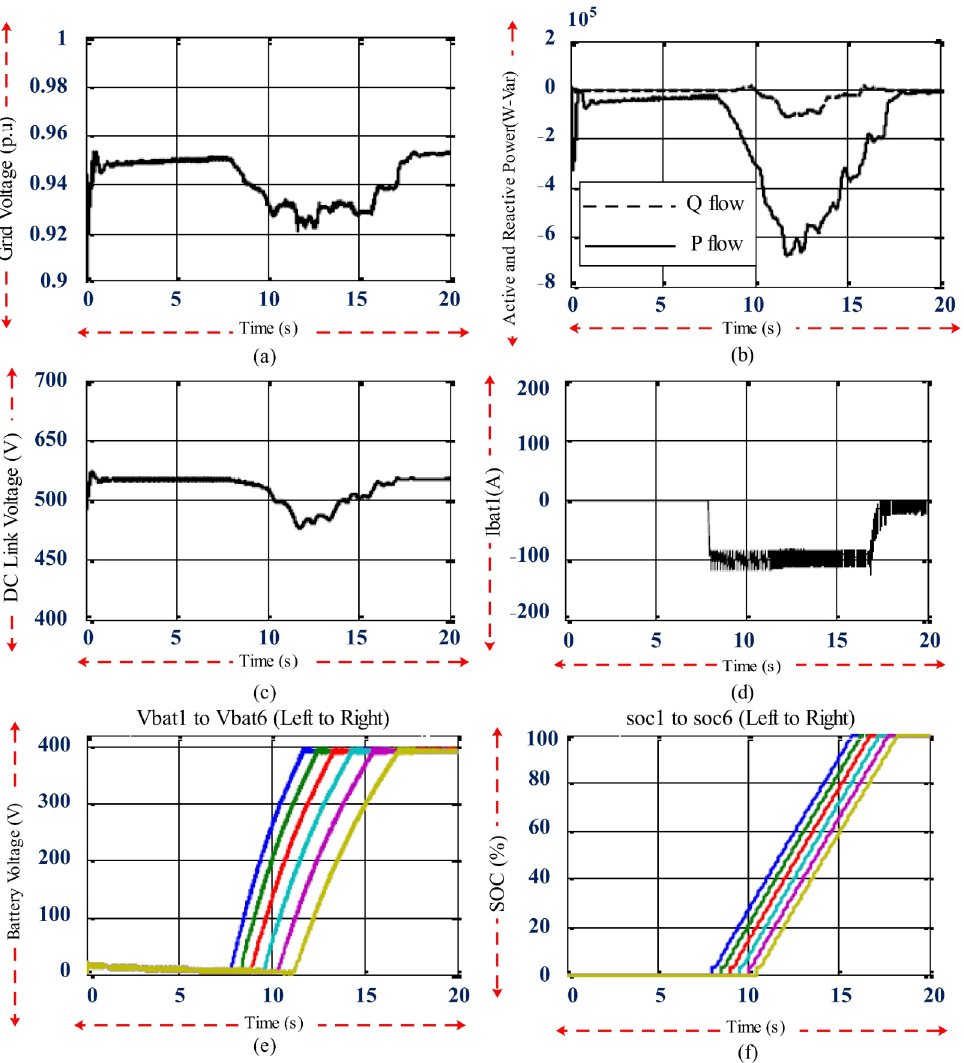
Figure 14. Fast charging results for EVs without reactive power compensation control. ( a ) Bus voltage; ( b ) exchange of active and reactive power; ( c ) link voltage; ( d ) battery current; ( e ) battery voltage in the SOC; ( f ) batteries.